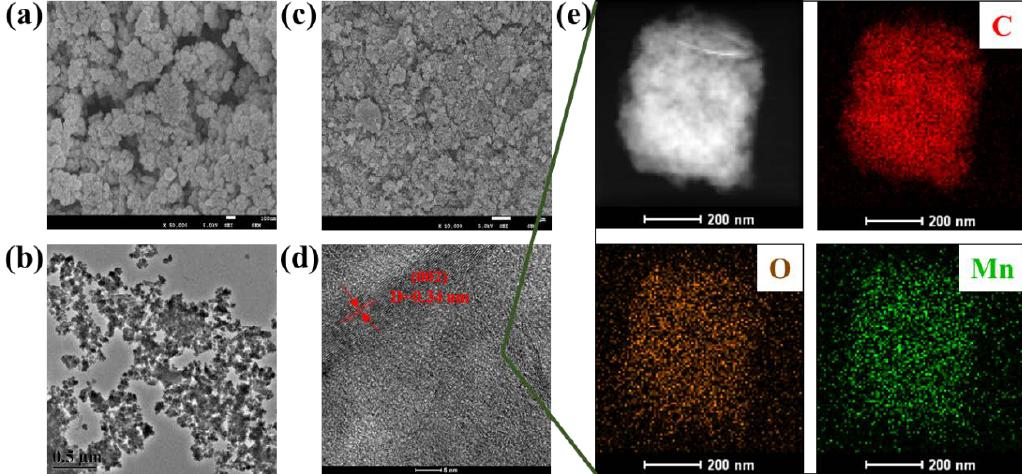
Figure 1. SEM ( a ) and TEM ( b ) images of MnO 2 NF; SEM ( c ) and HRTEM ( d ) images of MnO 2 NF/GO composites; and ( e ) HAADF-STEM image of MnO 2 NF/GO composites and corresponding elemental mapping images of C, O and Mn.